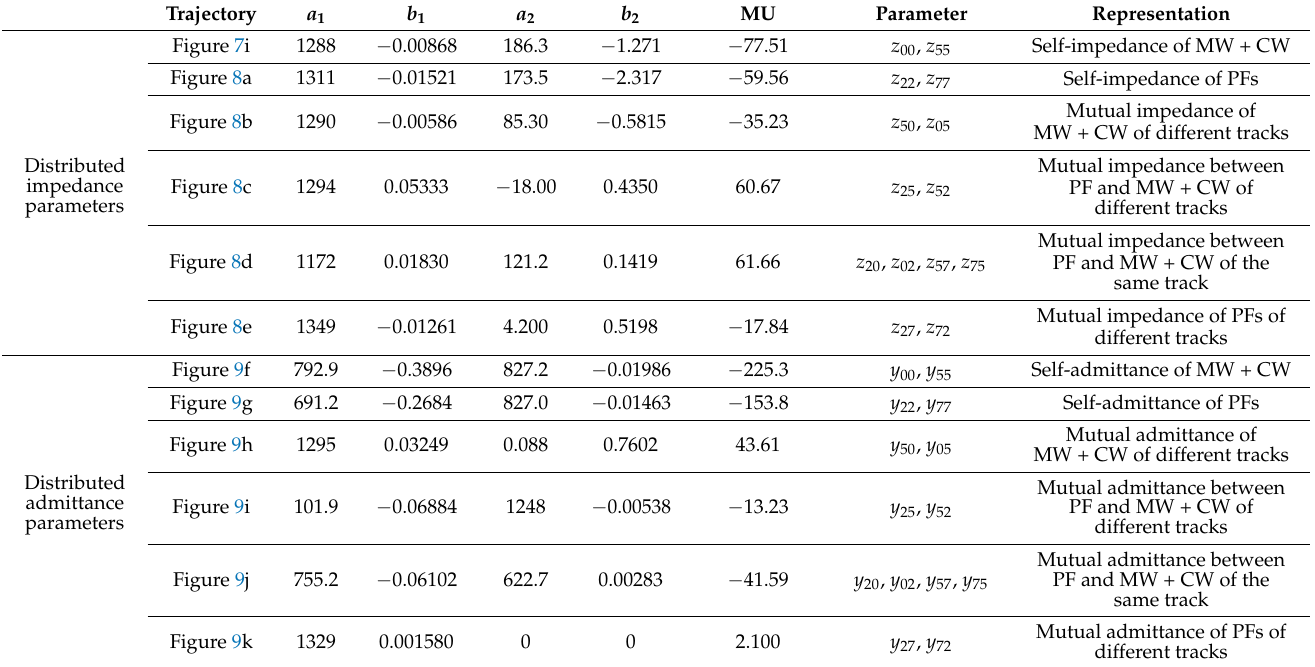
Table 3. Calculation results summary (four significant